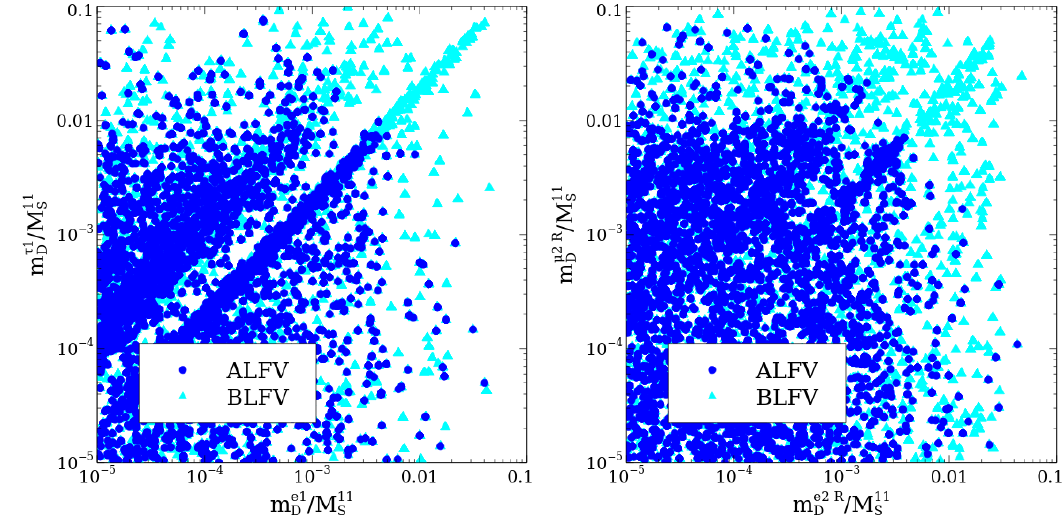
Figure 2 . Allowed parameter spaces after imposing the NOD constraints (cyan) and the NOD constraints plus LFV bounds (blue) are shown in the m e 1 in the m e 2 R – m µ 2 R plane in the right panel. ALFV and BLFV respectively correspond /M 11 /M 11 D S S D to after and before imposing the LFV